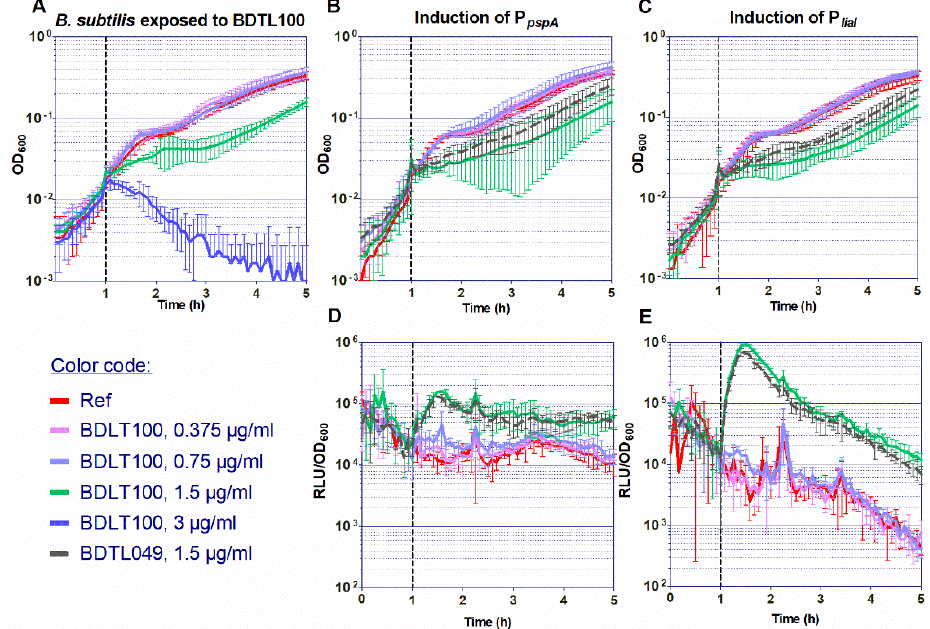
Figure 2. Sensitivity of B. subtilis cells toward BDTL100, and comparison of the induction of cell- envelope stress-reporter strains by BDTL100 and BDTL049. ( A ) The effect of the addition of increas- ing concentrations of BDTL100 on the growth of exponentially growing wild-type cells of B. subtilis W168 was determined by monitoring OD 600 over time. The time of antibiotic addition is indicated